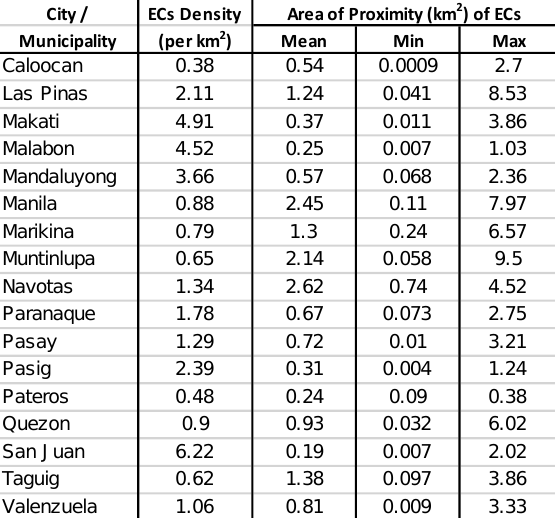
Table 2. Proximity distance (neighborhood) of evacuation centers in Metro